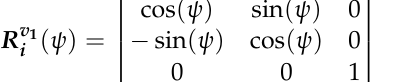
( θ ) represents the rotation around y -axis of the coordinate system Similarly, matrix R v 2 v 1 V 1 (defined by the previous rotation) for angle θ . The rotation creates a new local coordinate system V 2 whose y -axis is aligned with the y -axis of the coordinate system V 1 , while the x and z -axis of the coordinate system V 2 are rotated for angle θ with respect to the coordinate system V 1 .